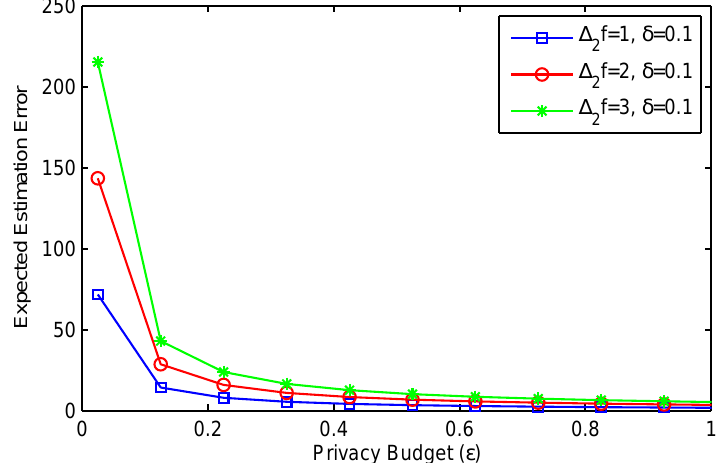
Figure 5. Expected estimation error of query results of Gaussian